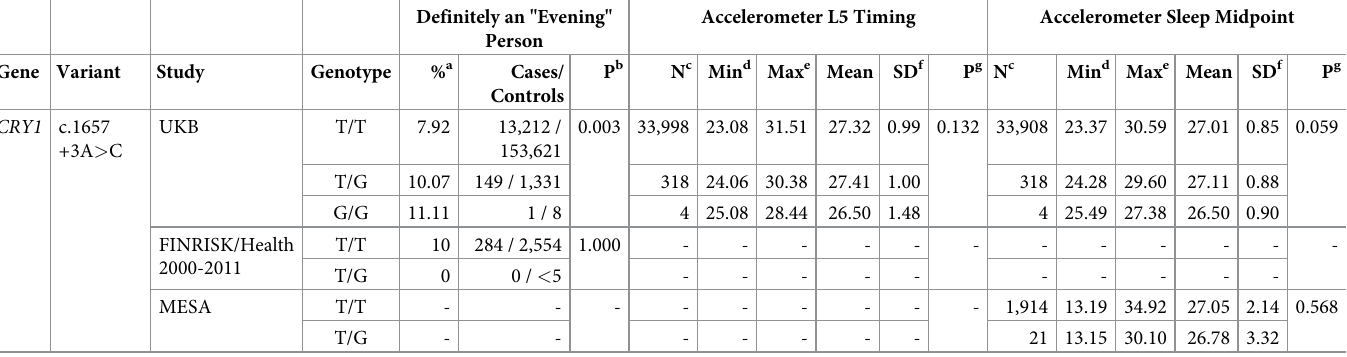
Table 5. Proportion of individuals self-reporting as being “definitely an evening person”, average L5 timing, and average sleep-midpoint across all nights for each genotype group of the CRY1 variant previously reported to be causal for delayed sleep phase disorder in the UK Biobank (UKB), Finnish and MESA studies. Accel- erometer based estimates of sleep timing unavailable in the Finnish studies. Self-reported “eveningness” and accelerometer estimates of L5-timing unavailable in